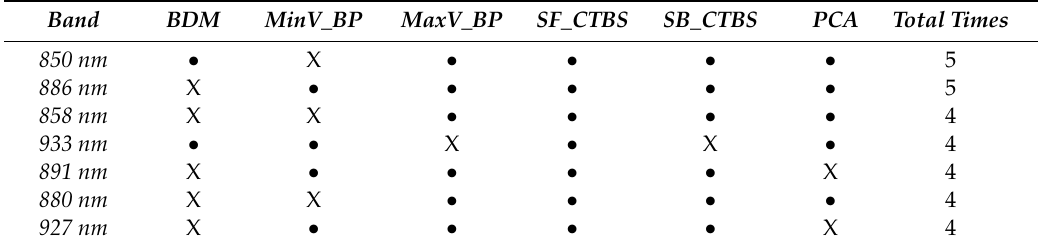
Table 3. Most frequently selected bands by six band selection algorithms in the first 20 bands. ( ● : include, X: not include).